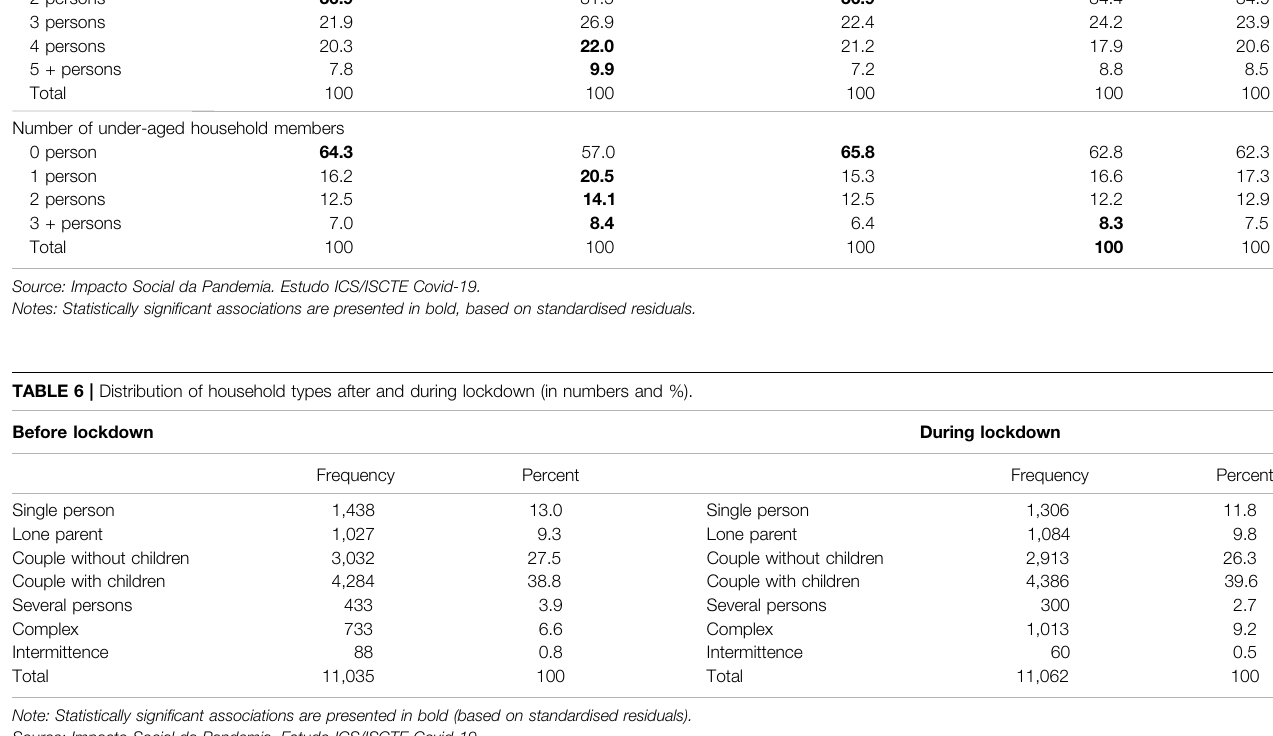
Materially comfortable- subjectively constrained